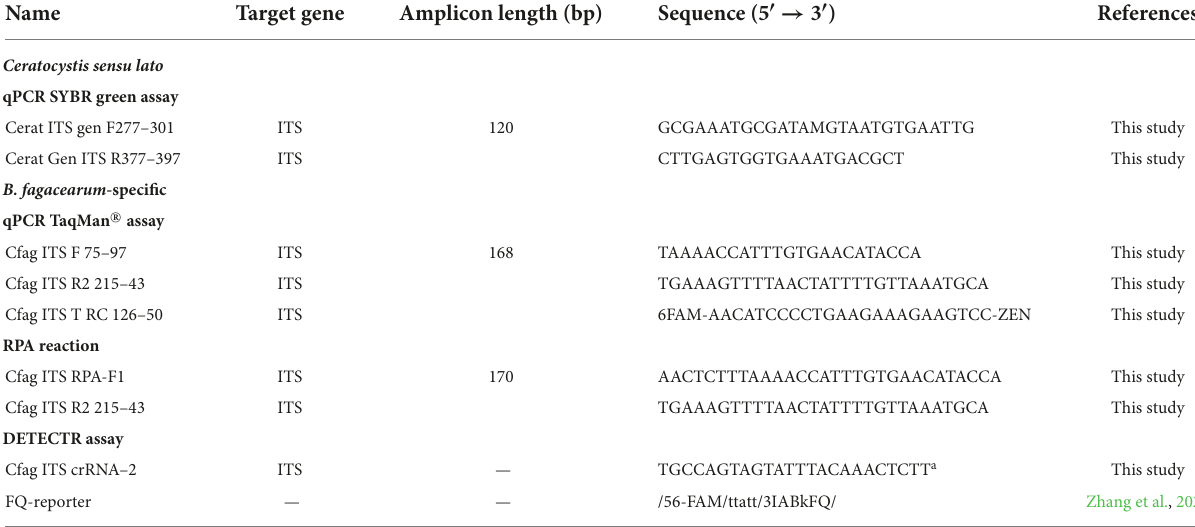
TABLE 1 Primers and probe used for genus-specific qPCR SYBRGreen, species-specific qPCR TaqMan R (cid:13) , and DETECTR